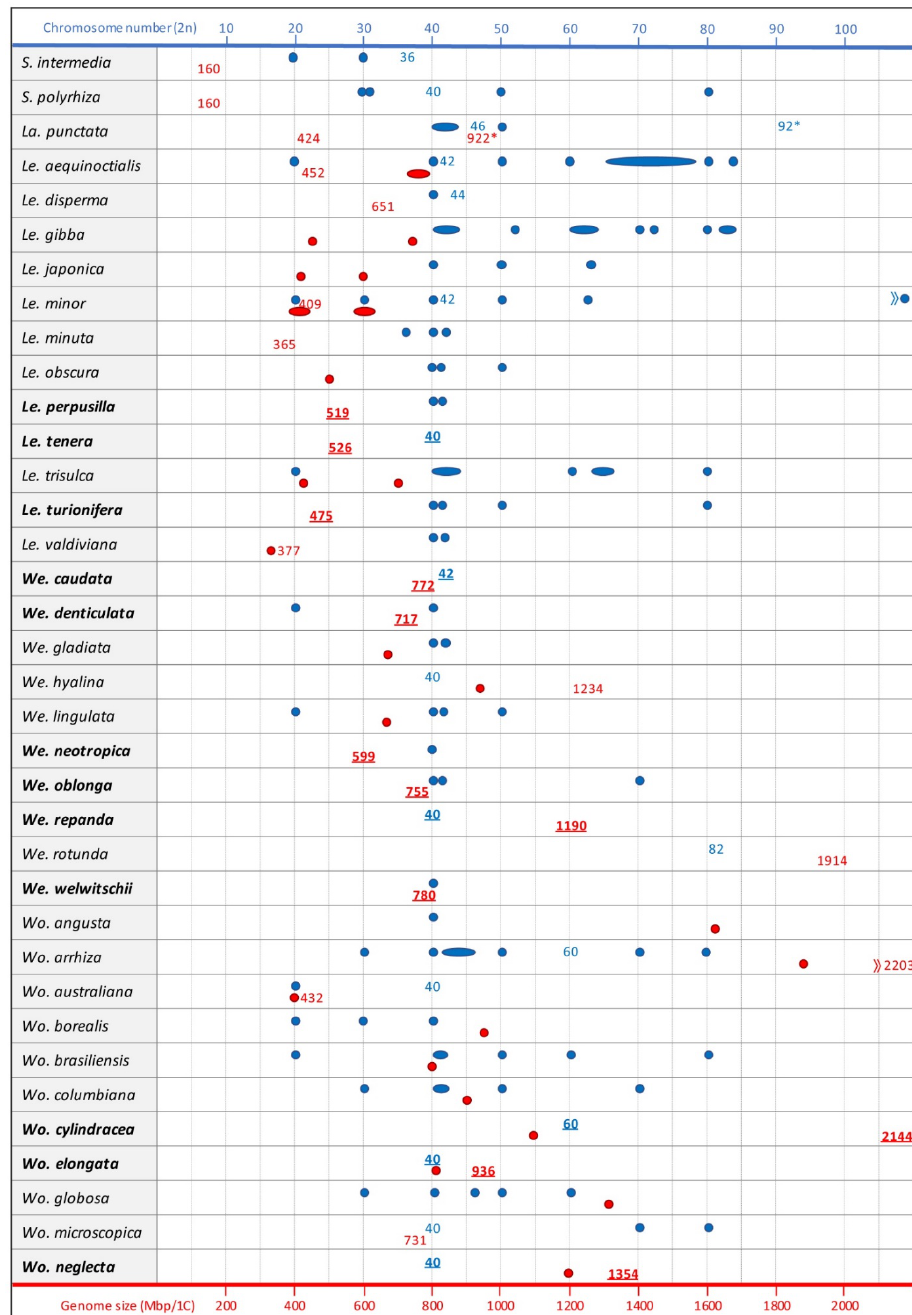
Figure 1. Chromosome number (blue) and genome size (red) of duckweeds. When chromosome numbers and genome sizes refer to newly investigated species or were taken from [2] or [3] ( Le. minuta ), they appear as numbers. For references to other chromosome counts (blue dots and ovals [for closely adjacent values]) see [2]. Other genome size estimations (red dots and ovals) were from [4]. The values for Le. perpusilla 8539 (519 Mbp), Le. tenera 9024 (526 Mbp), Le. turionifera 8693 (475 Mbp), We. caudata 9165 (772 Mbp); We. denticulata 8221 (717 Mbp), We. neotropica 8848 (599 Mbp), We. oblonga 9391 (755 Mbp), 2 n = 42), We. repanda 9062 (1190 Mbp, 2 n = 40), We. welwitschii 9469 (780 Mbp), Wo. cylindracea 9056 (2144 Mbp; 2 n = 60), Wo. elongata 9188 (936 Mbp; 2 n = 40), Wo. neglecta 9149 (1354 Mbp; 2 n = 40) were obtained by flow-cytometry and determined in this paper. Species for which we provide in this paper the first or new values are in bold and the corresponding values are underlined. * indicates the values for the colchicine-induced tetraploid La. punctata clone